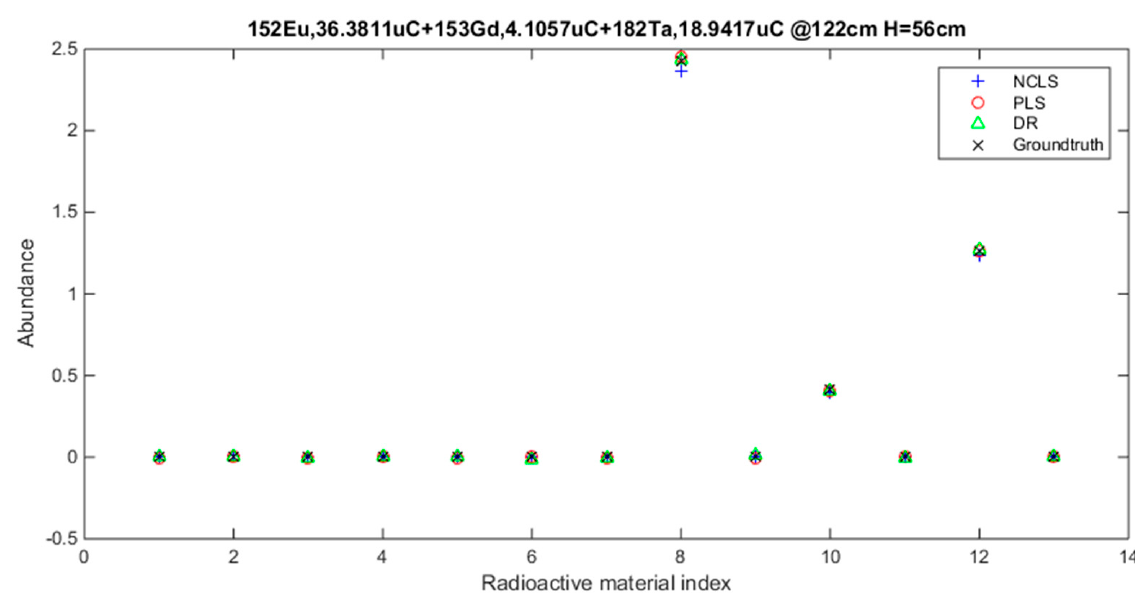
Figure 9. Three-source mixture mixing-rate estimation example (source = background − subtracted foreground) from high mixing-rate dataset, (RMSE values: NCLS: 0.0181, PLS: 0.0090, DR: 0.0066).